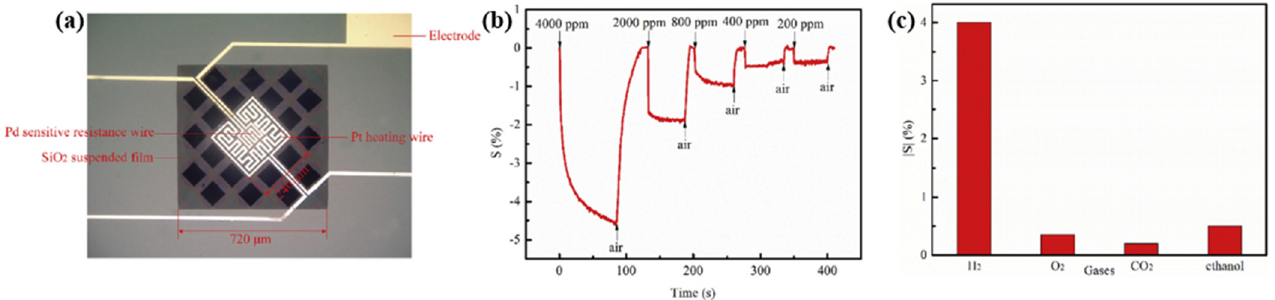
Figure 7. ( a ) Microscope image of a hydrogen sensor sample. ( b ) Responses of different H 2 concentrations at 400 °C, and ( c ) responses of the sensor to various gases (4000 ppm) at 400 °C [59]. Copyright (2019), with permission from Elsevier.